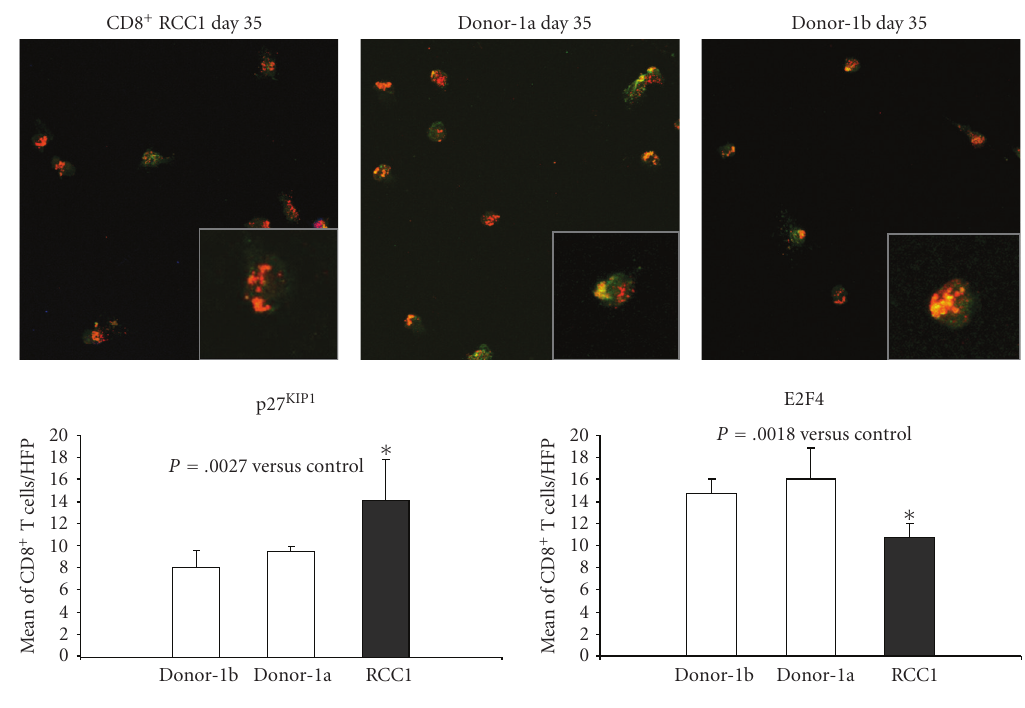
Figure 8: Altered expression of E2F4 in RCC patient CD8 + T cells. CD8 + T cells were surface-labeled with anti-p-p27 KIP1 (red) and anti-E2F4 (green) mAbs and the performance of confocal microscopy analysis. Quantitative analysis of HPF was carried out by confocal microscopy software (Leica, TCS-SP2; Student’s t -test, P < . 05). Data are from 1 of 5 experiments, that all gave comparable results.